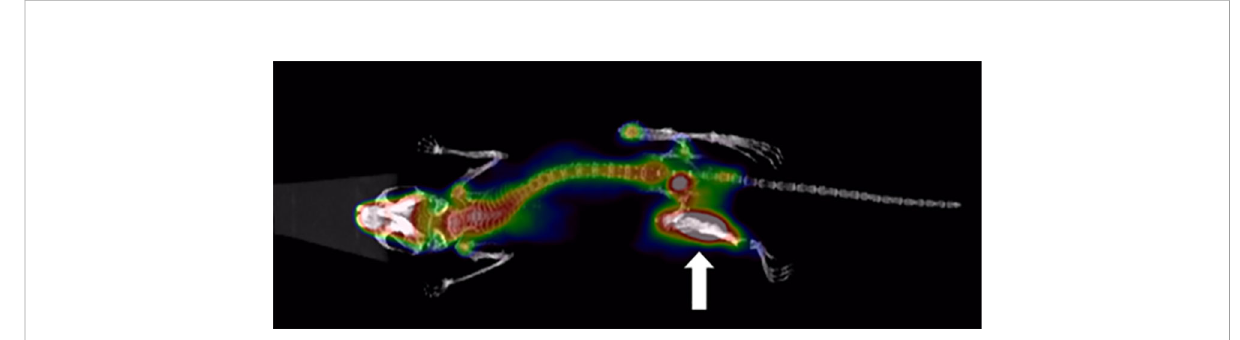
FIGURE 5 BALB/c nude mice (PC-3) after injection of 0.2 mCi 68 Ga- DOTA-IBA PET/CT imaging (1.5h).